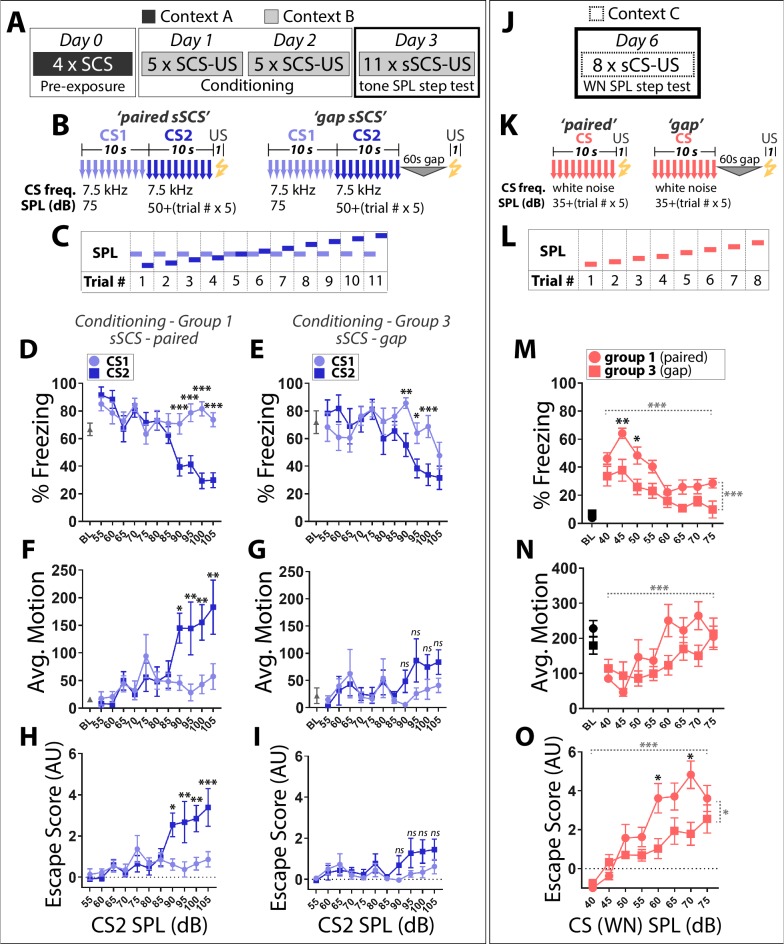
Stimulus intensity, not training order, determines the defensive behaviors elicited by SCS stimuli.(A) Mice conditioned in groups 1 and 3 (Figure 1) were run through a tone SPL step test on day 4. (B) The tone step SCS (sSCS) is composed of two 7.5 kHz tone stimuli in which CS1 is held constant at 75 dB while CS2 begins at 55 dB and is stepped up by 5 dB each trial. (C) Schematic of tone SPL step test. (D,E) Percentage time spent freezing. (F,G) Average motion. (H,I) Escape score. Paired sSCS (D, F, H); n = 15); gap sSCS (E, G, I); n = 10). Asterisks indicate significant difference between stimuli for a given trial. ns, not significant. (J) On day 6, a WN SPL step test was done in a novel context. (K) The WN step CS (sCS) is a white noise stimulus which begins at 40 dB and is stepped up by 5 dB each trial. (L) Schematic of WN SPL step test. (M) Percentage time spent freezing, (N) average motion, and (O) escape score. Paired sSCS (D,F,H; n = 15); gap sSCS (E,G,I; n = 10). Black asterisks indicate significant difference between groups for a given trial. Dashed horizontal gray brackets indicates significant main effect of SPL. Statistical comparisons were 2-Way Repeated Measures ANOVA, with Trial and Stimulus as factors. Dashed vertical gray brackets indicate significant main effect of group. Error bars indicate SEM.Figure 3—source data 1.Raw data used to generate freezing, motion, and escape score plots.Figure 3—source data 2.All statistical tests and significant comparisons with F and P values.